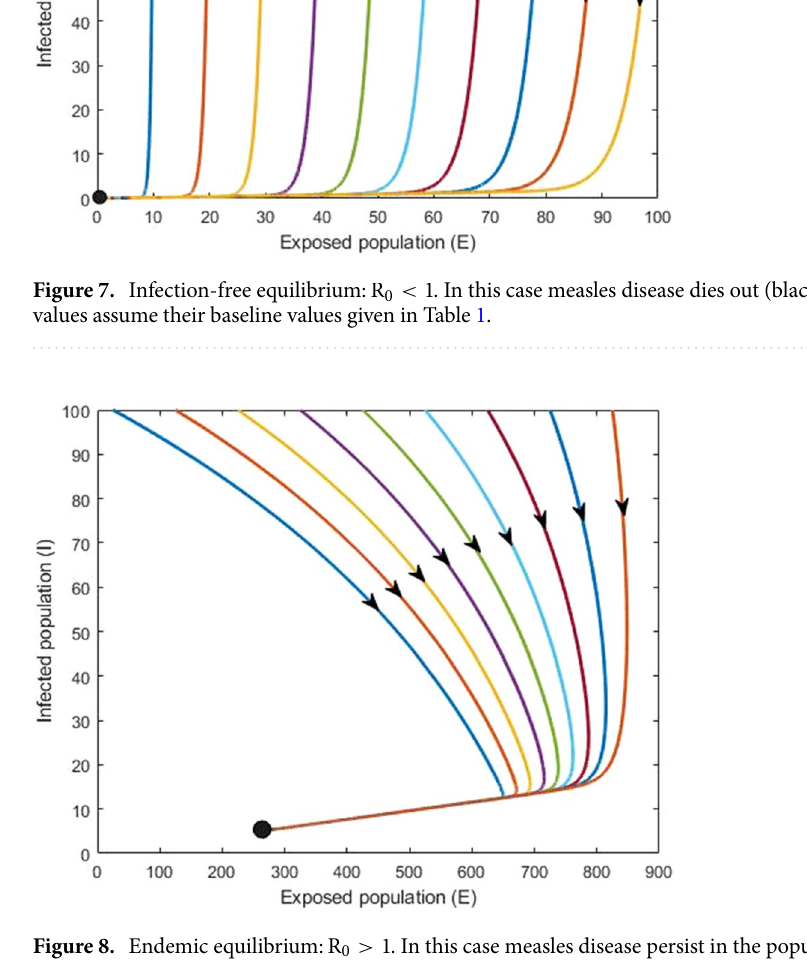
Figure 8. Endemic equilibrium: R 0 > 1 . In this case measles disease persist in the population (black dot). All parameter values assume their baseline values given in Table